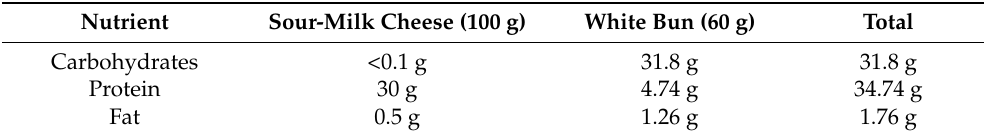
Table 2. Nutritive value of provided